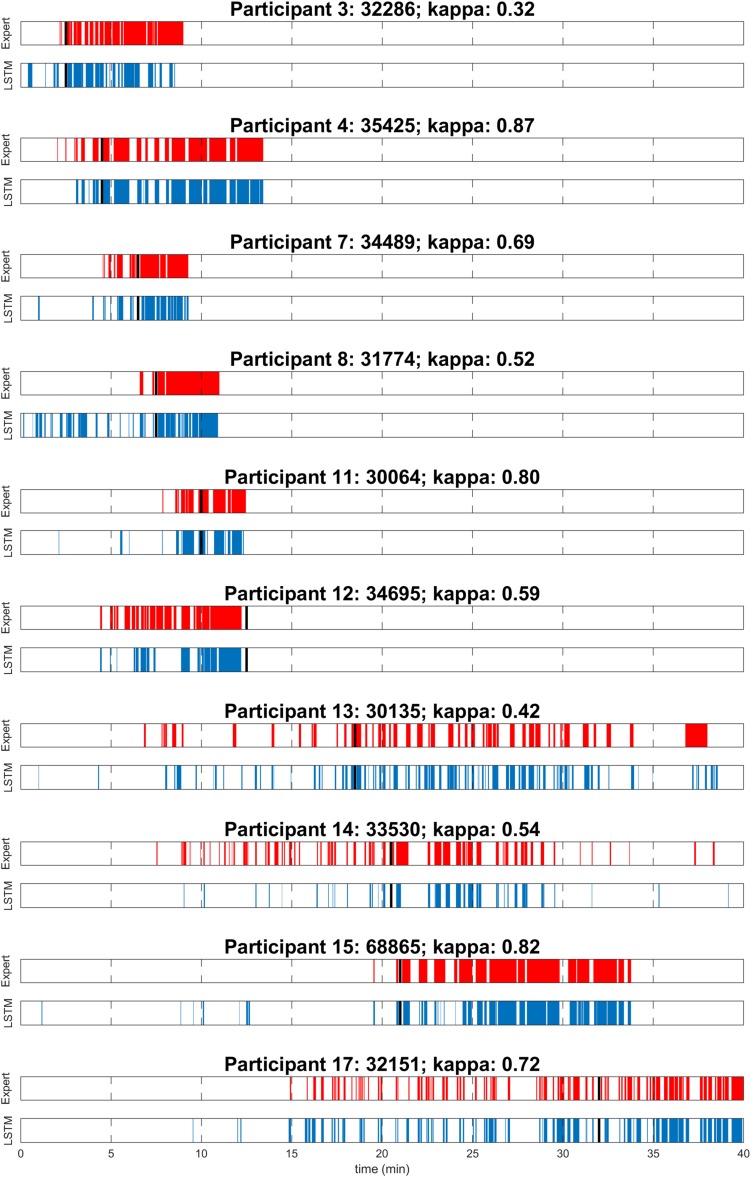
Visual expert scoring (red) and automatic detection with long short-term memory neural network (LSTM; blue) of microsleep episodes (MSEs) for each of the 10 participants assessed in the maintenance of wakefulness test (MWT) after sleep deprivation. Sleep onset is indicated (black). Participants are numbered according to Figure 3A.